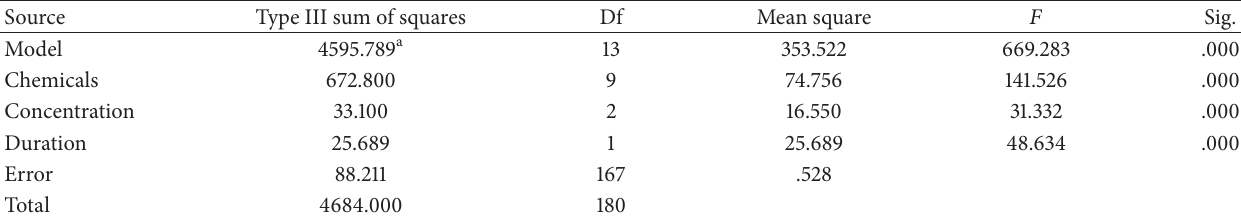
Table 2: ANOVA for laboratory bioassay of different insecticidal treatments against adult females of hibiscus mealybug.